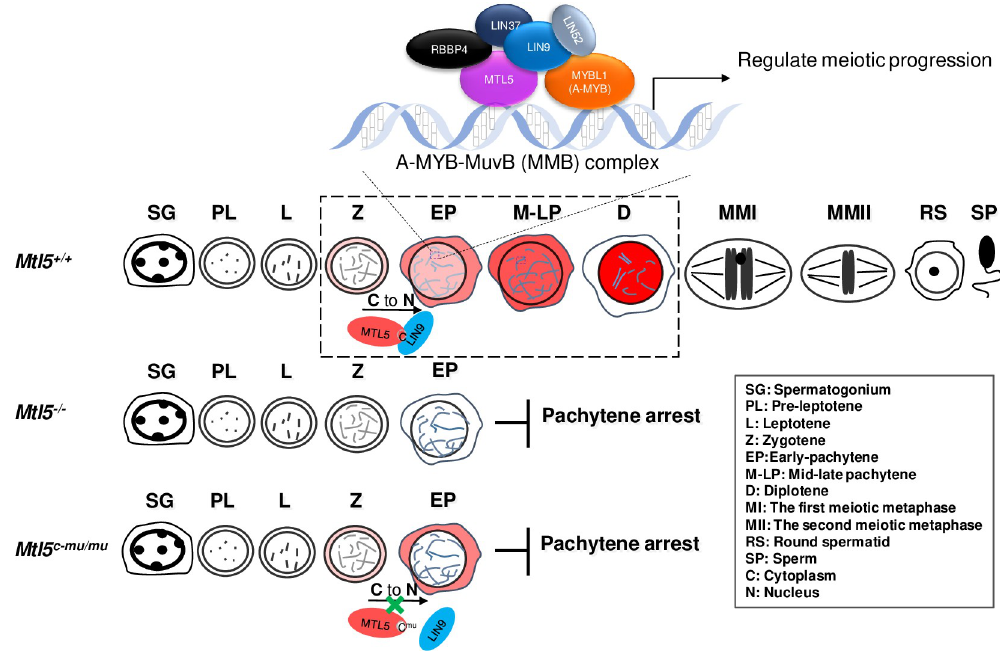
Fig 7. A predicted brief work model of MTL5 in regulating male meiosis. C to N represent MTL5 translocated from cytoplasm (C) to nucleus (N).